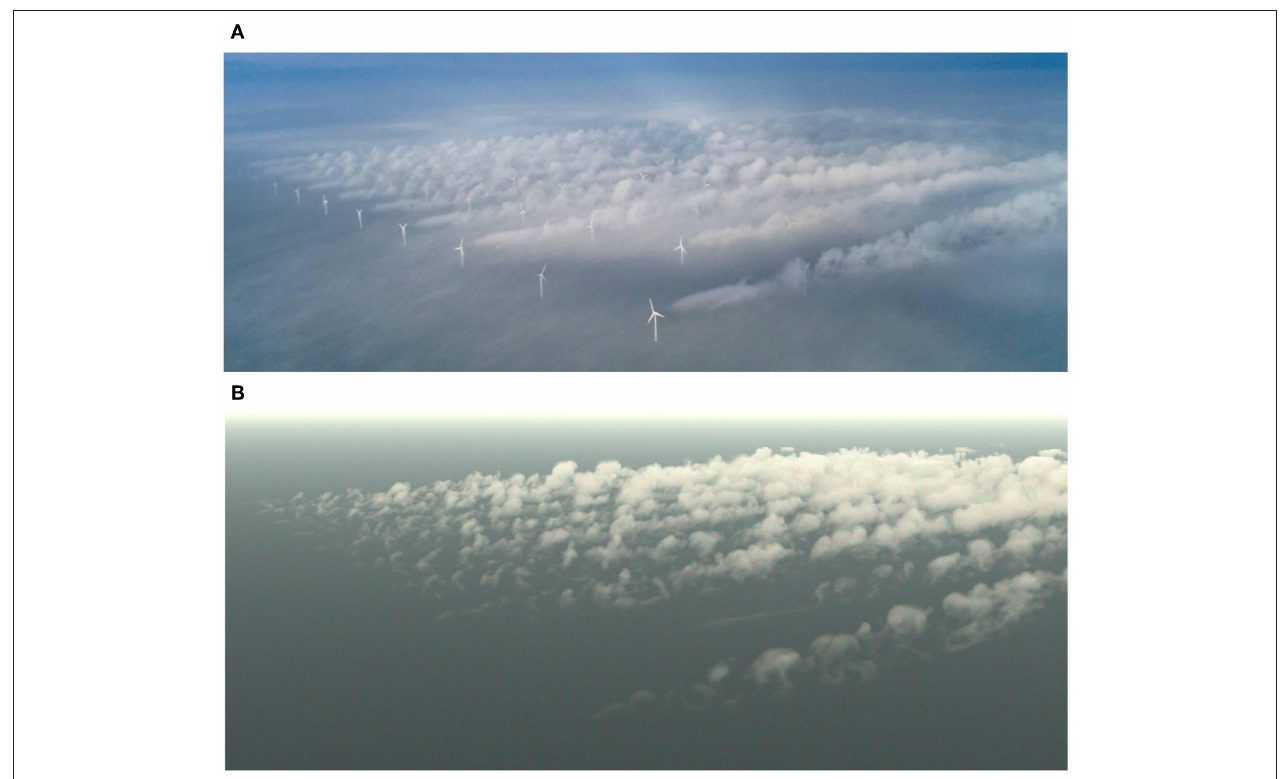
FIGURE 13 | (A) Photograph of the Horns Rev 1 wind farm (12/02/2008 around 10:10 UTC) from southeast (Hasager et al., 2013). Courtesy Vattenfall. Photographer: Christian Steiness. (B) Post-processing (see Villefranque et al., 2019) of simulated cloud mixing ratio. Wind turbines are not